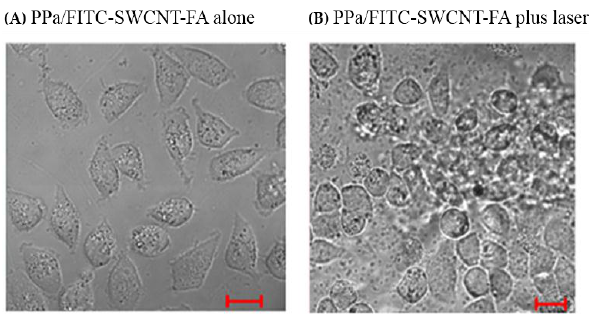
Figure 6. Typical optical microscopy images of HeLa cells treated with PPa/FITC-SWCNT-FA alone ( A ) and PPa/FITC-SWCNT-FA and laser ( B ). Scale bar, 20 μm.